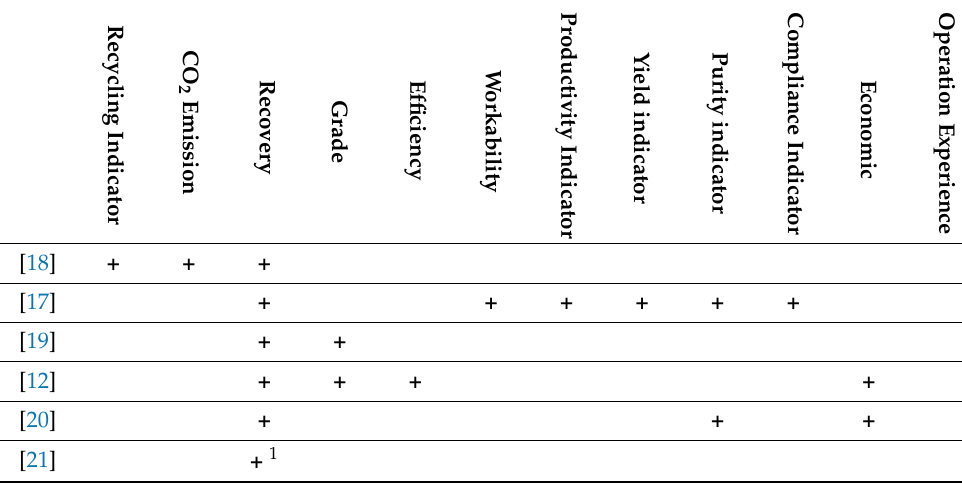
Table 1. Indicators used in the literature to evaluate waste treatment